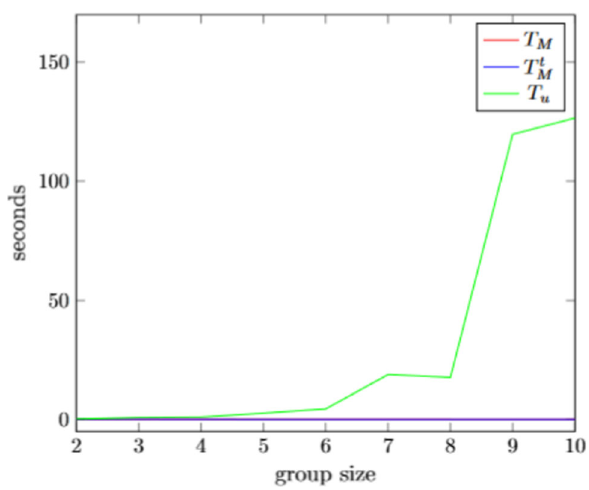
Fig. 1 Comparison of the MaxSAT transformations T u , T M and T t Each instance has 60 variables. Solving time with RC2 in